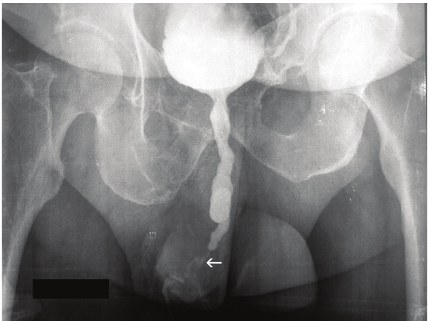
Figure 1: Descending cystourethrogram showing severe stenosis of the penile urethra (arrow).